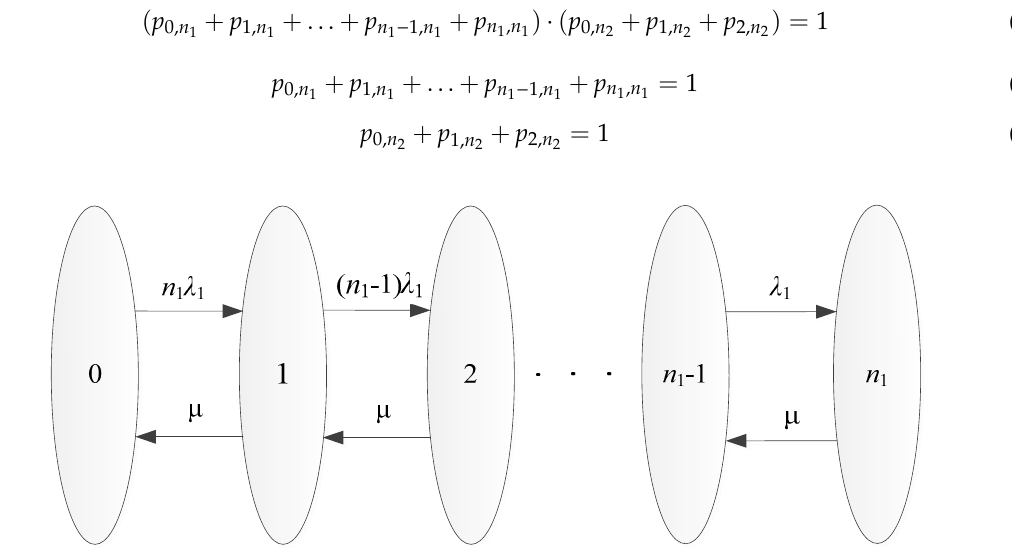
Figure 5. States of n 1 constant-speed chillers and possible transitions.